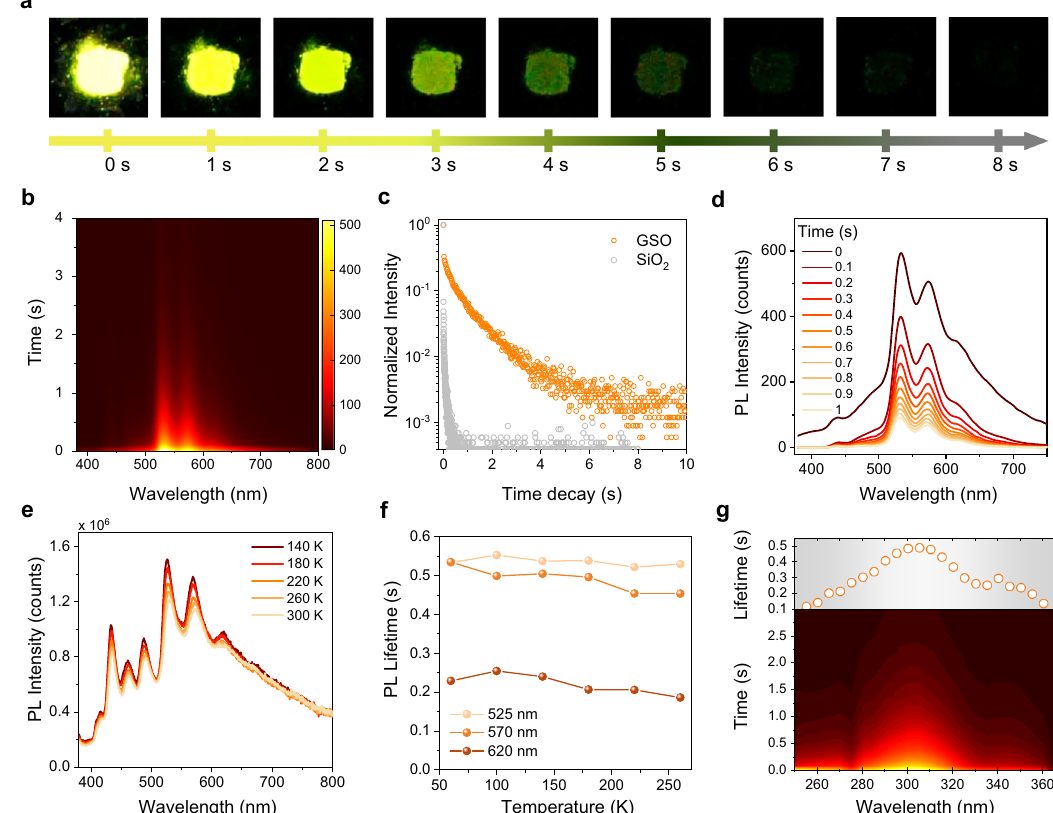
Fig. 3 | Stabilization of ultra-long phosphorescence by the incorporation of Si and Ge centres. a time-scale photographs of GSO powder recorded after the 365nm UV excitation was switched off. b Time-resolved emission spectroscopy (TRES) of Sample III recorded at300K after the removal of the 300nm excitation. The pseudo-colour change from bright yellow to dark red indicates the gradual decreaseofemissionintensityafterremovingtheexcitationsource.Thecolourbar shows PL counts. c PL lifetime decay curves of sample III (GSO annealed at 800 o C) andcontrolsampleSiO 2 , λ ex =300nm. λ em =525nm. d Time-resolvedPLspectraof Sample IIIrecorded at300K after removing the 300nm excitation. Peak positions